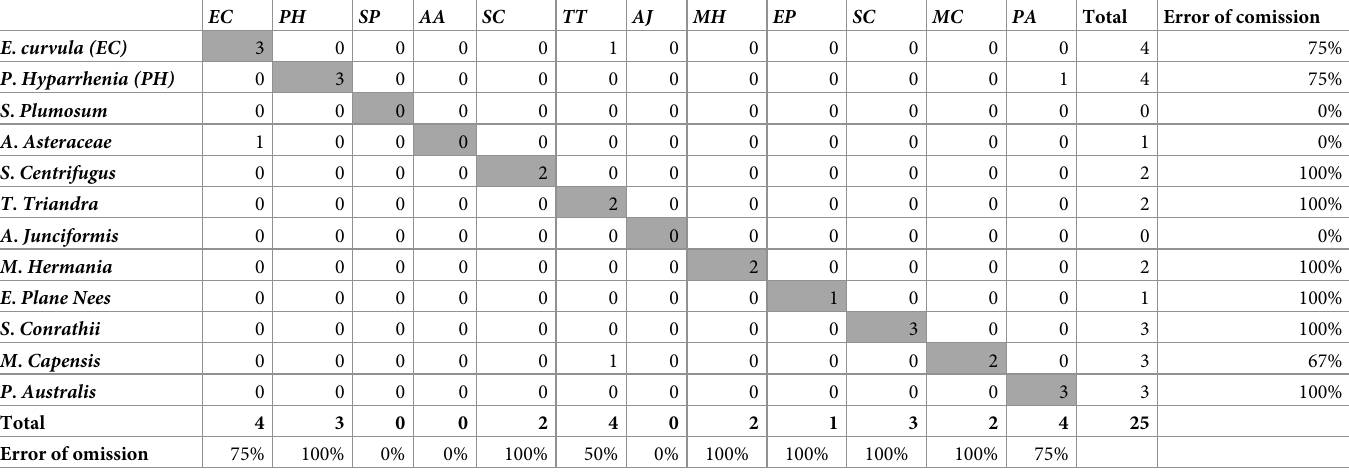
Table 3. Confusion matrix for Landsat 7